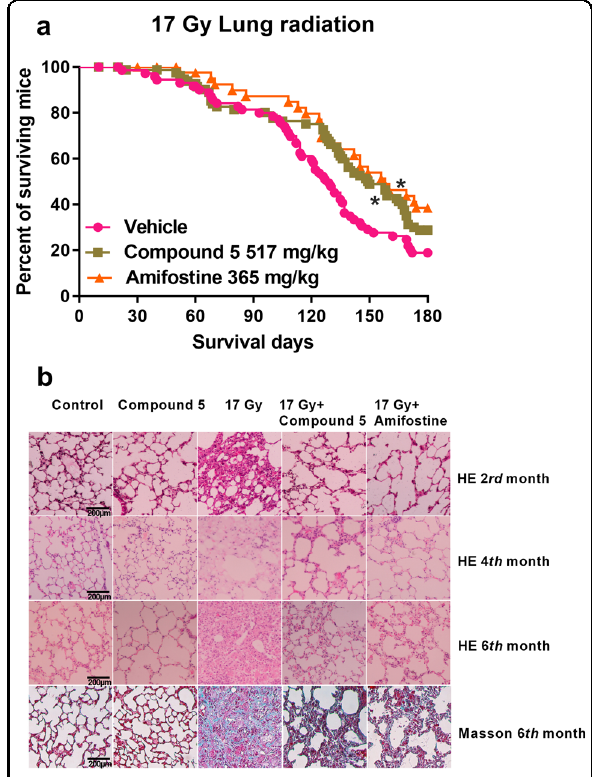
Fig. 5 Compound 5 alleviated radiation-induced lung injury. Mice were administered with NS, compound 5 , and amifostine 20 min before exposure to 17 Gy lung radiation as described in the “ Materials and methods ” section. a Survival rate of mice exposed to 17 Gy lung irradiation; b representation images of HE and Masson trichrome staining show the lung tissue sections; * p < 0.05 vs 17 Gy, N = 69 in vehicle group, N = 80 in compound 5 group, N = 39 in amifostine